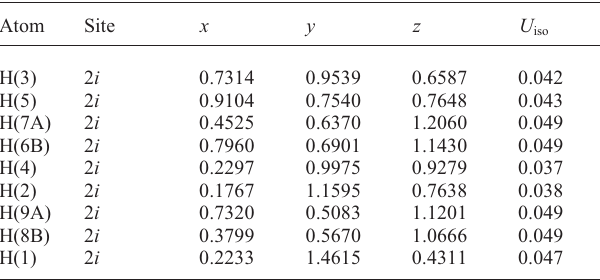
Table 2. Atomic coordinates and displacement parameters (in Å 2 )